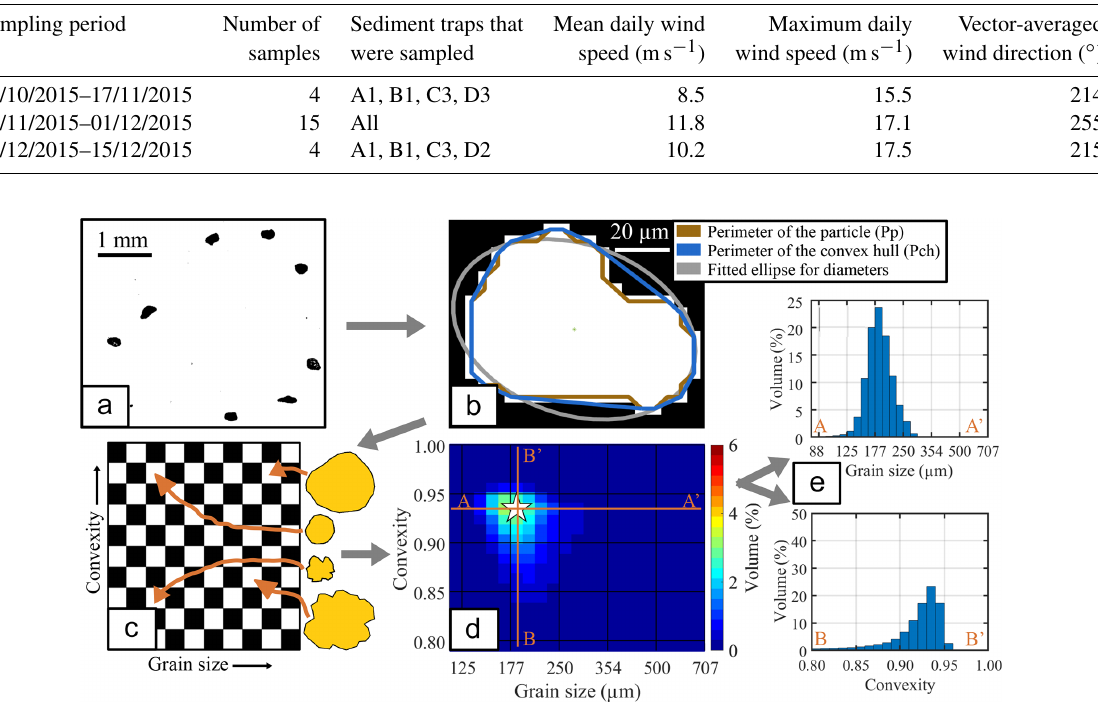
Figure 2. (a) Binary image of sediment grains. (b) Computation of particle characteristics (note inversed black–white scale). (c) Assign- ment of grains to size–shape classes. (d) Grain size–shape distribution (ConD2d in the example; star marker designates the mode of the distribution). (e) Grain size (upper panel) and grain shape (lower panel) cross sections through the SSD along respectively A–A’ and